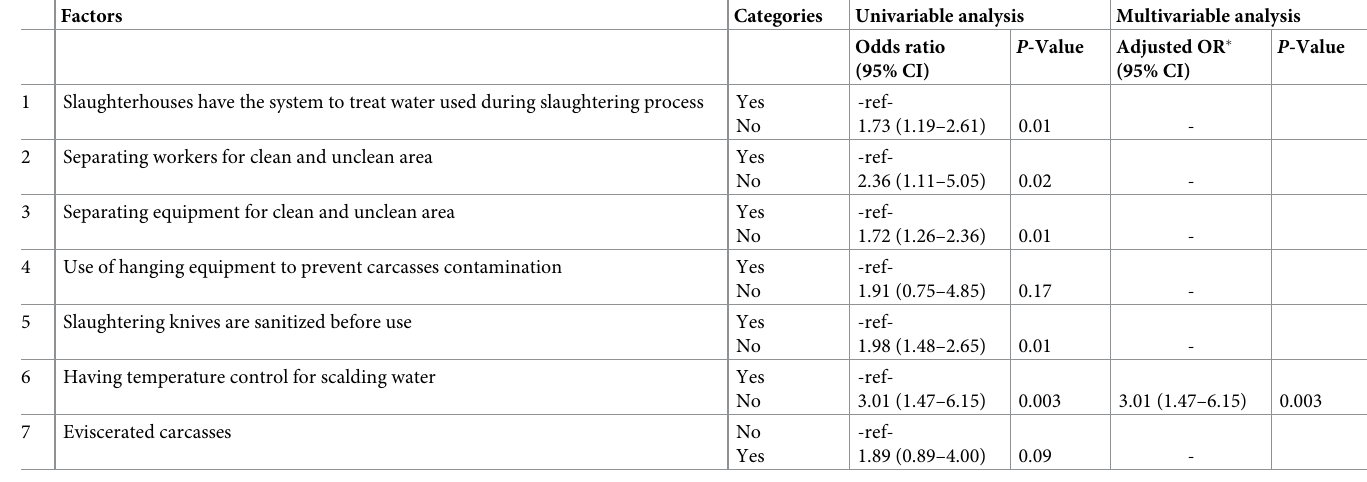
Table 5. Factors associated with the coliforms non-compliance of meat samples based on the univariable and multivariable mixed-effects logistic regression. Factors